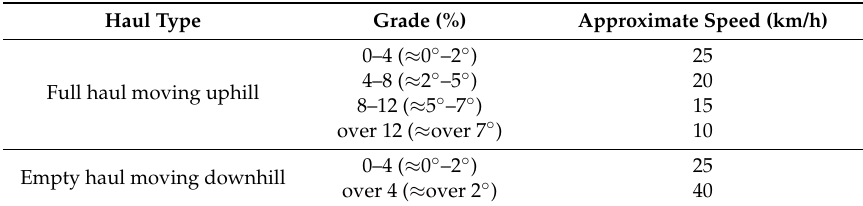
Figure 12. Input data set for least-cost path analysis. ( a ) Digital elevation model of the study area (resolution = 5 m). ( b ) Vertical factor graph. ( c ) Horizontal factor graph. Table 3. Approximate speed of dump truck (100 ton) according to the slope-gradient of the haul road in an open-pit mine